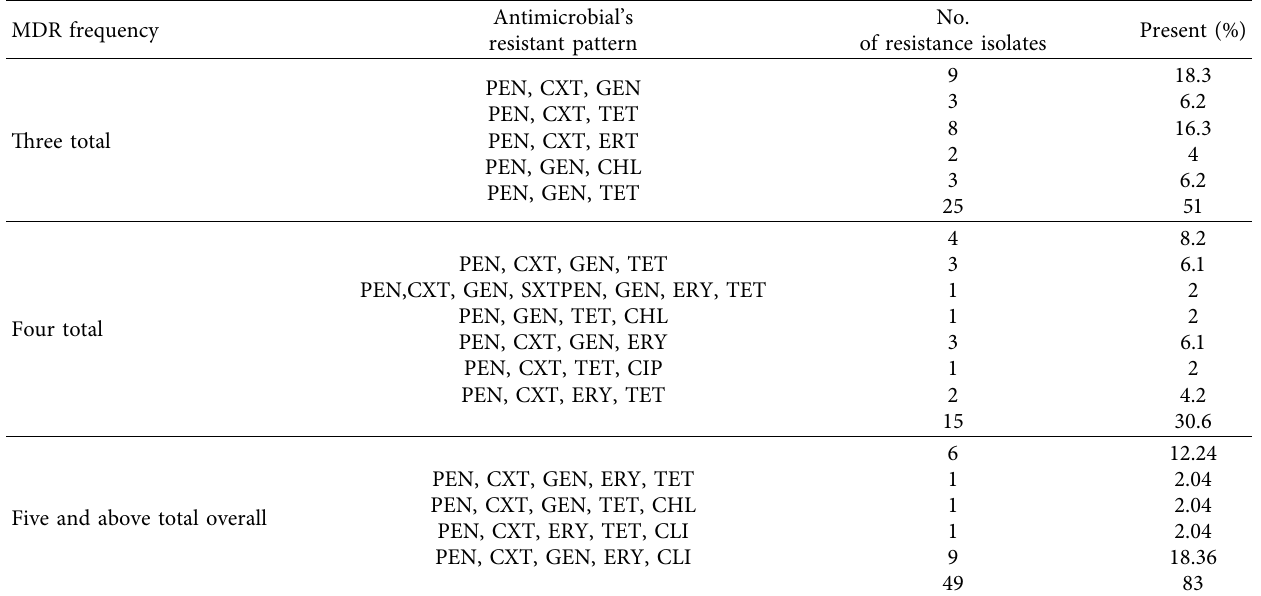
Table 6: Patterns of MDR of S. aureus isolates from raw cow milk in the study